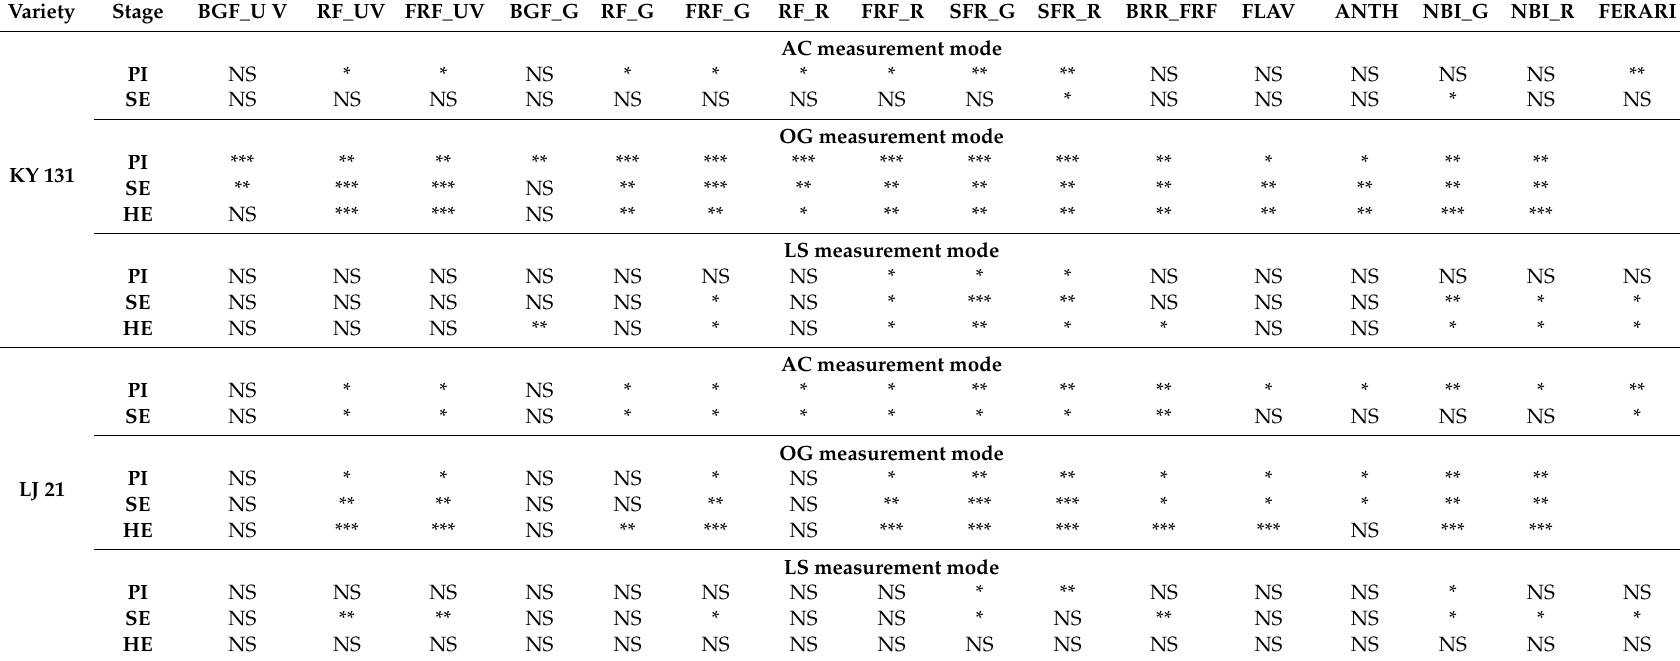
Table 3. Significance test (ANOVA) of Multiplex variables measured in three modes across 5 N rates: Above canopy (AC), “on-the-go” (OG), and leaf scale (LS) at the panicle initiation (PI), stem elongation (SE), and heading (HE) growth stages for the rice varieties Kongyu 131 (KY 131) and Longjing 21 (LJ 21) in 2013.